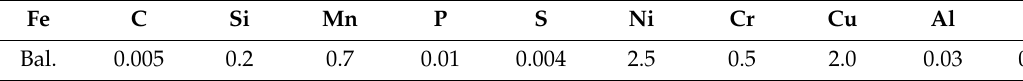
Table 1. Chemical composition of the tested steel in mass %.